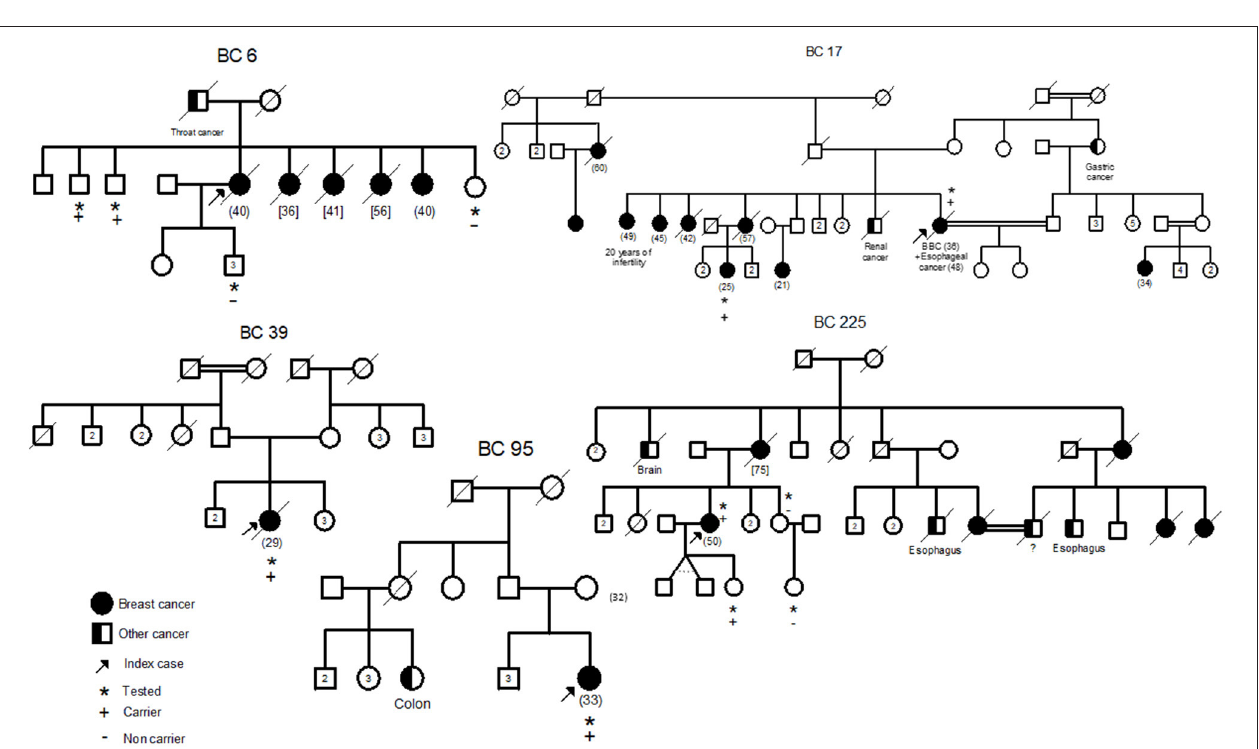
Frontiers in Genetics |